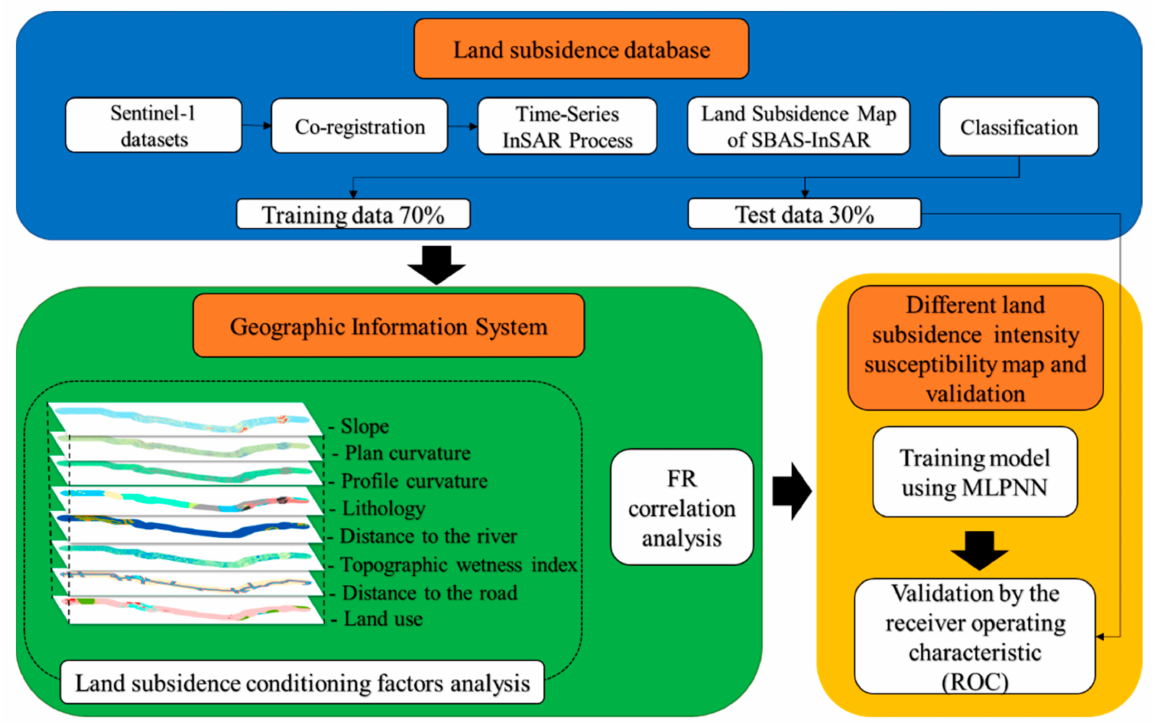
Figure 3. The study